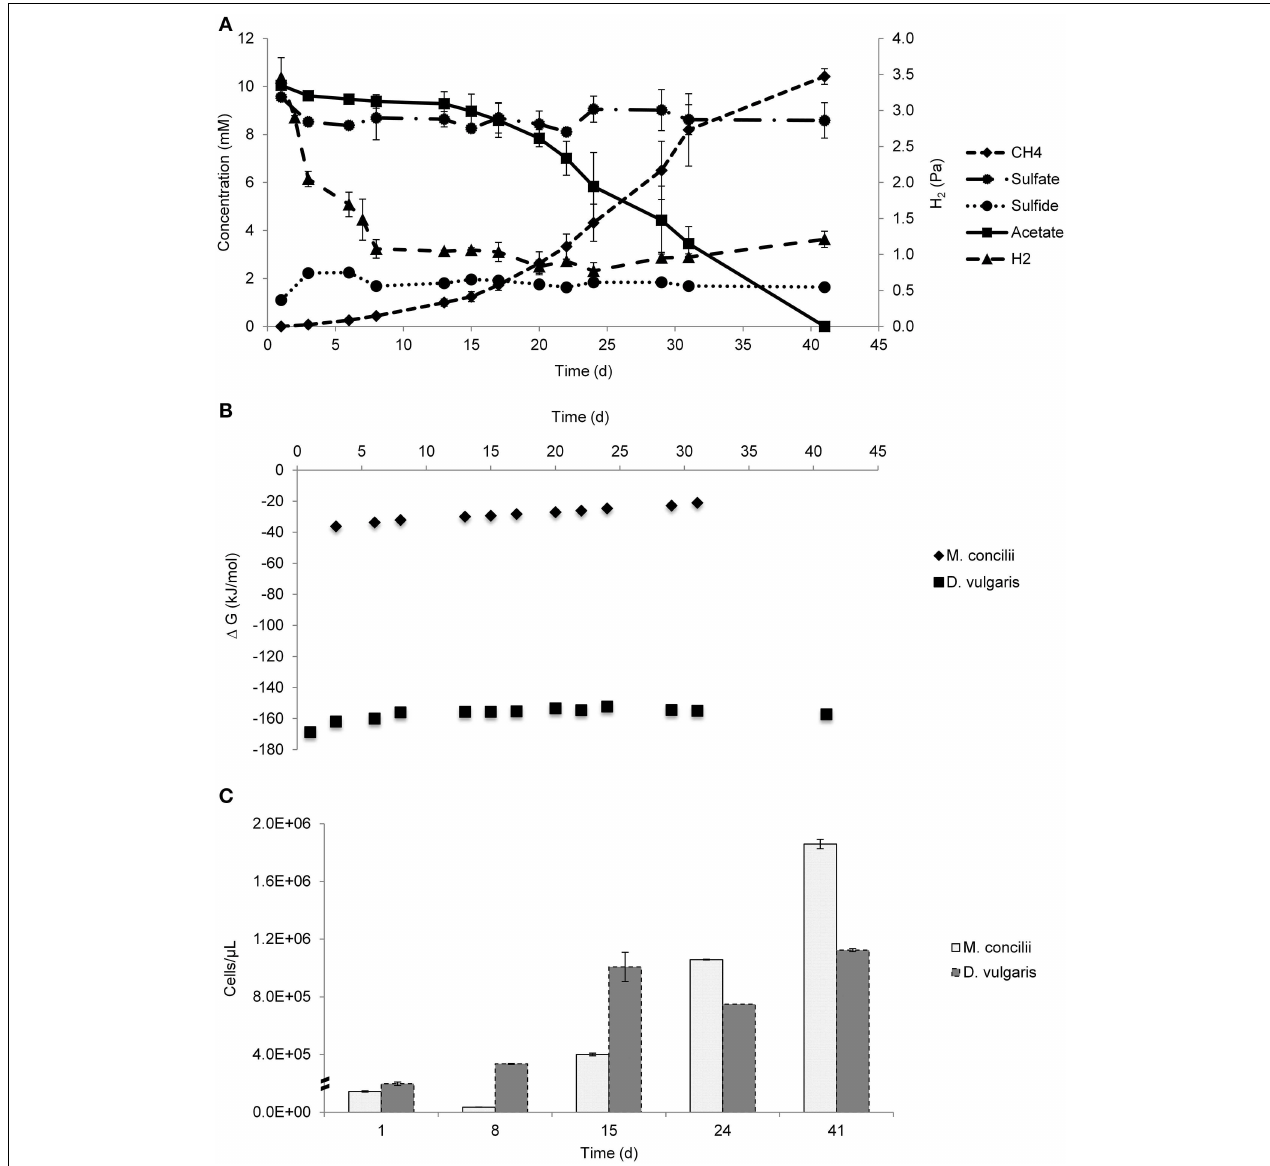
acetate degradation to sulfide and bicarbonate and methane formation from acetate. (C) Growth quantified by qPCR in cells/ µ l. All data is average of 2 replicate